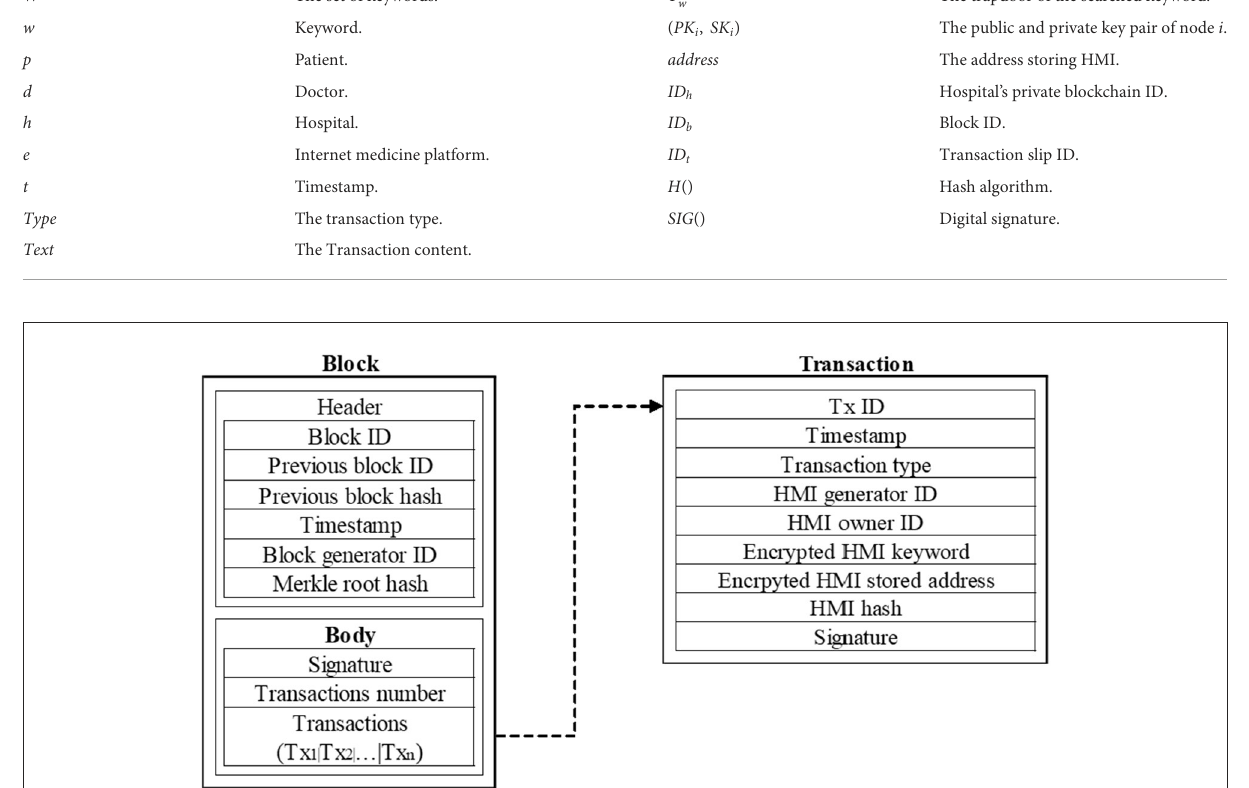
FIGURE3 Structure of a block in the hospital’s private